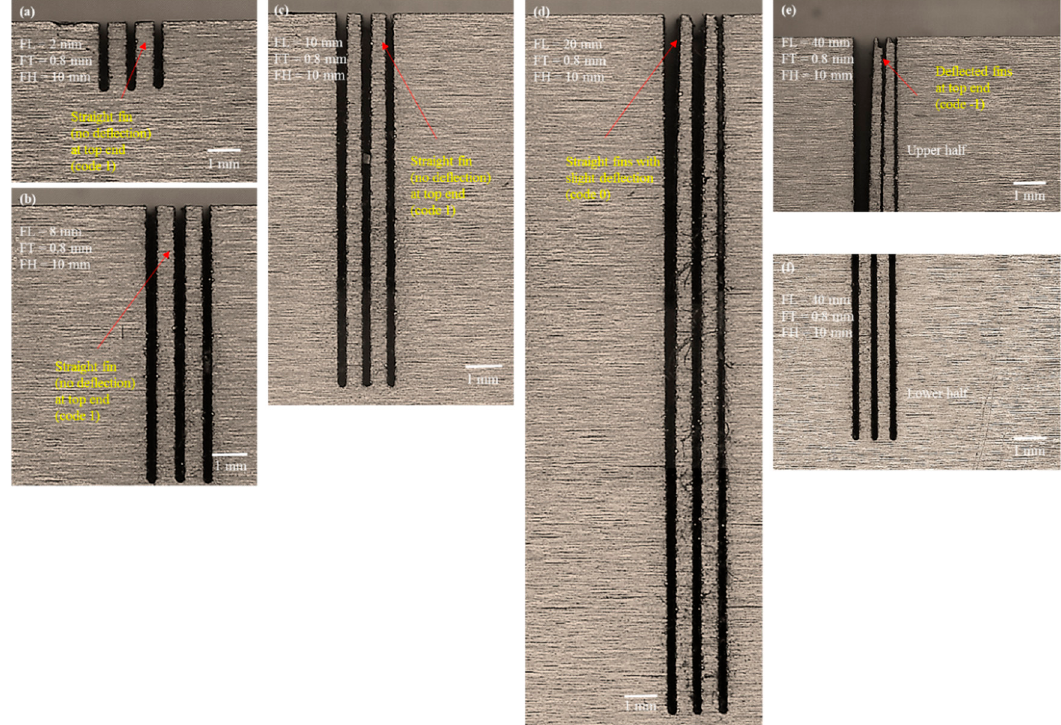
Figure 14. Microscopic analysis of structure traits in the fourth phase of experimentation with designed fin thickness (FT_d) of 0.8 mm and FH 10 mm: ( a ) FL 2 mm, ( b ) FL 8 mm, ( c ) FL 10 mm, ( d ) FL 20 mm, ( e ) FL 40 mm upper half, ( f ) FL 40 mm lower half.